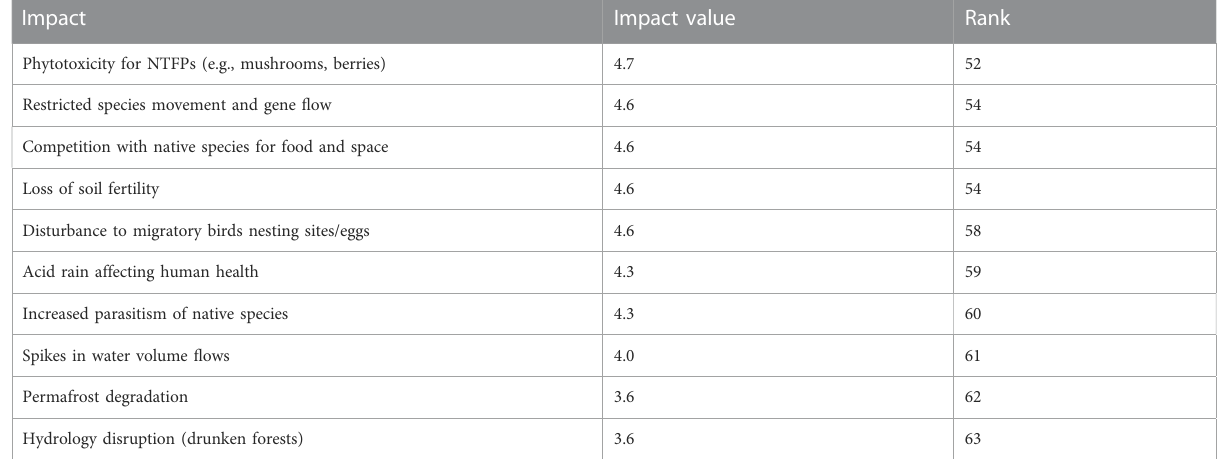
TABLE 5 Ten least-ranked